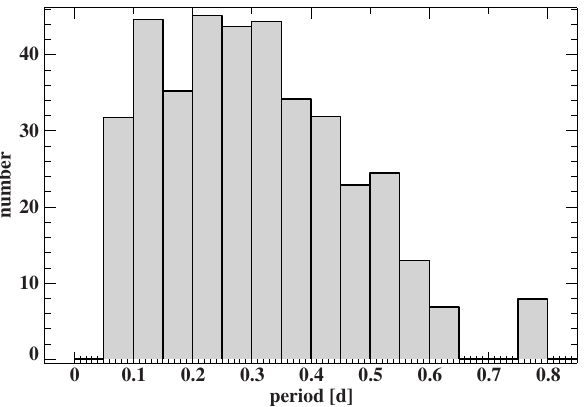
Figure 5. Preliminary period distribution of the OGLE HW Vir candi- dates corrected for the eclipse